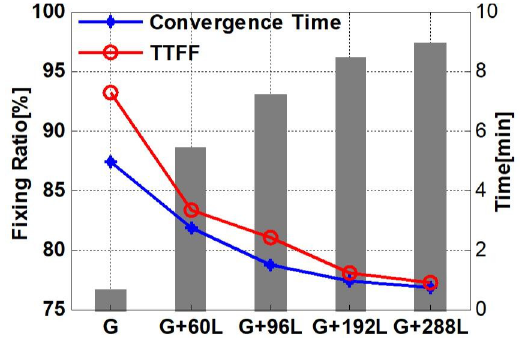
Figure 5. Average convergence time, time to first fix (TTFF), and fixing ratio of GPS RTK solutions in combination with different LEO constellations, for ‘P339-P341′ baseline scheme.